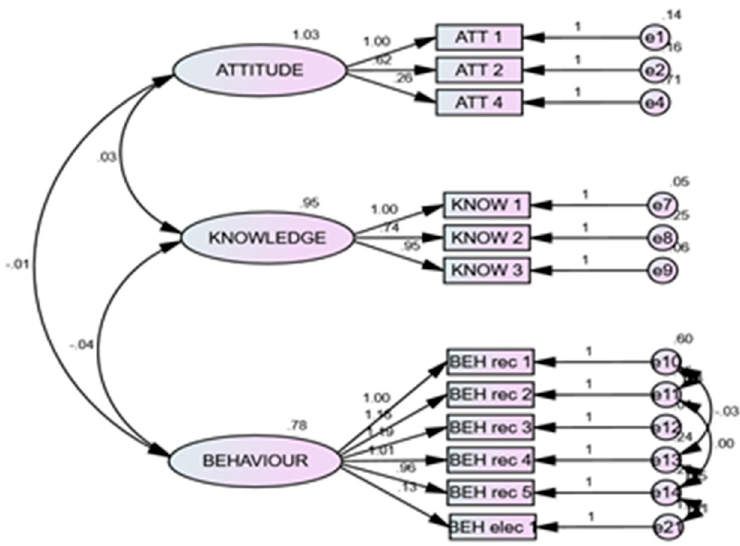
Figure 9. Best fitting measurement model of interrelations among building occupants’ environmental AKB after Step 3 (Final Measurement Model).